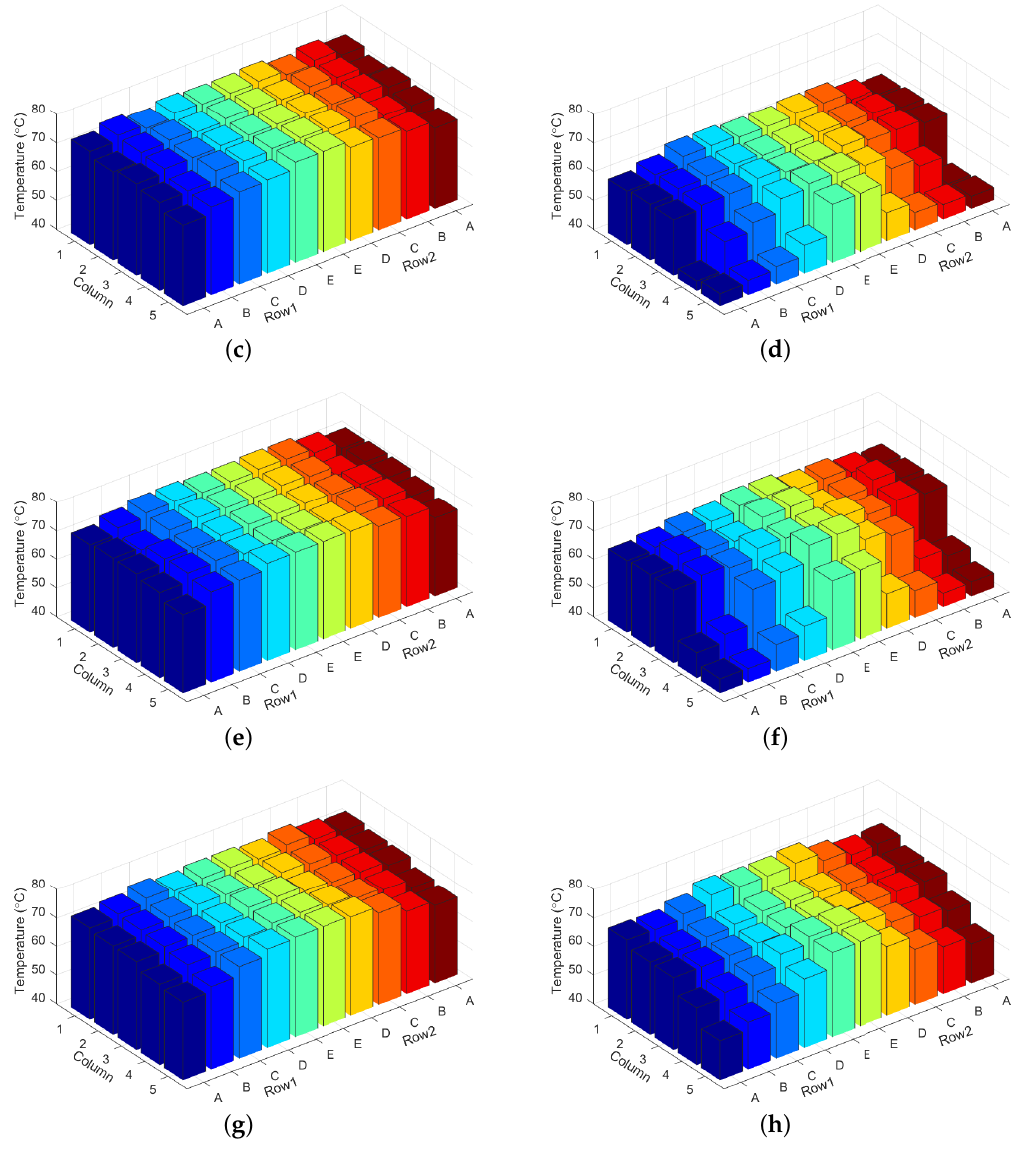
Figure 7. Chip temperature distributions achieved by different strategies under constant-flow cooling air supply. ( a ) Chip temperature-aware workload allocation, 30% data center utilization. ( b ) Inlet temperature-aware workload allocation, 30% data center utilization. ( c ) Chip temperature-aware workload allocation, 50% data center utilization. ( d ) Inlet temperature-aware workload allocation, 50% data center utilization. ( e ) Chip temperature-aware workload allocation, 70% data center utilization. ( f ) Inlet temperature-aware workload allocation, 70% data center utilization. ( g ) Chip temperature-aware workload allocation, 90% data center utilization. ( h ) Inlet temperature-aware workload allocation, 90% data center